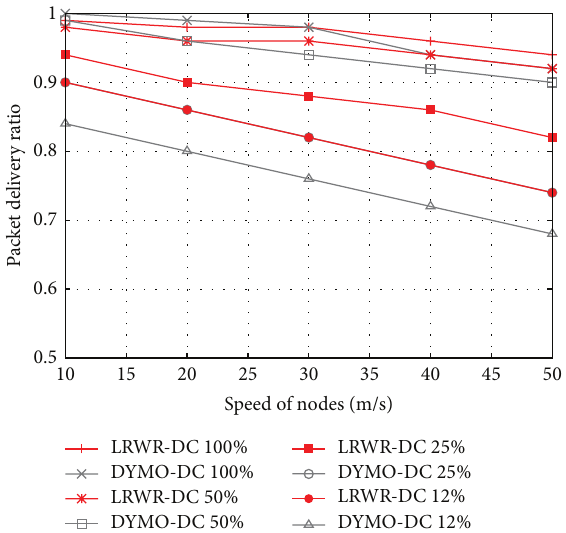
Figure 8: Packet delivery ratio versus speed of nodes. Figure 9: Mean delay versus speed of